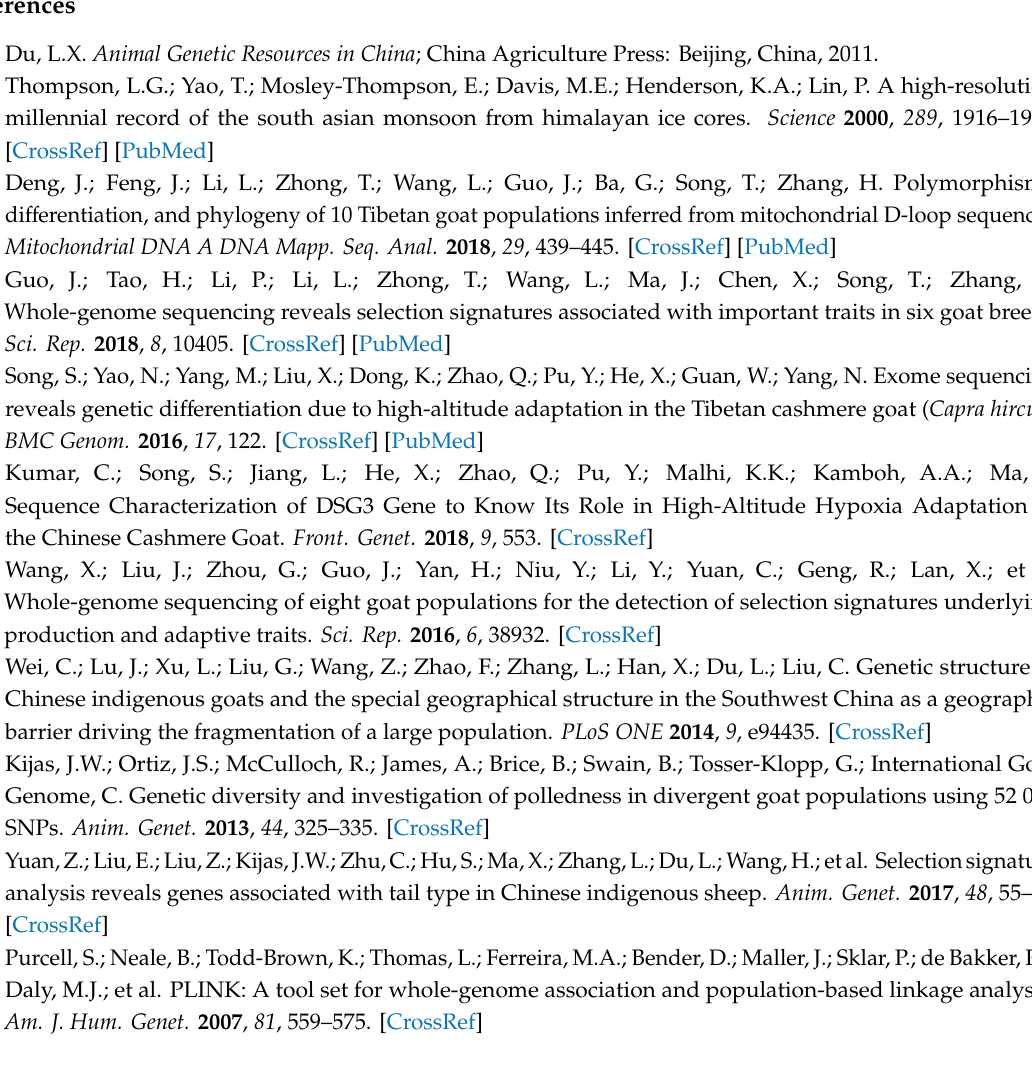
Table S1: Primers used in this study for q-PCR. Table S2: Putatively selected loci were defined as genetic regions in overlapped windows with extremely high di values (top 1%